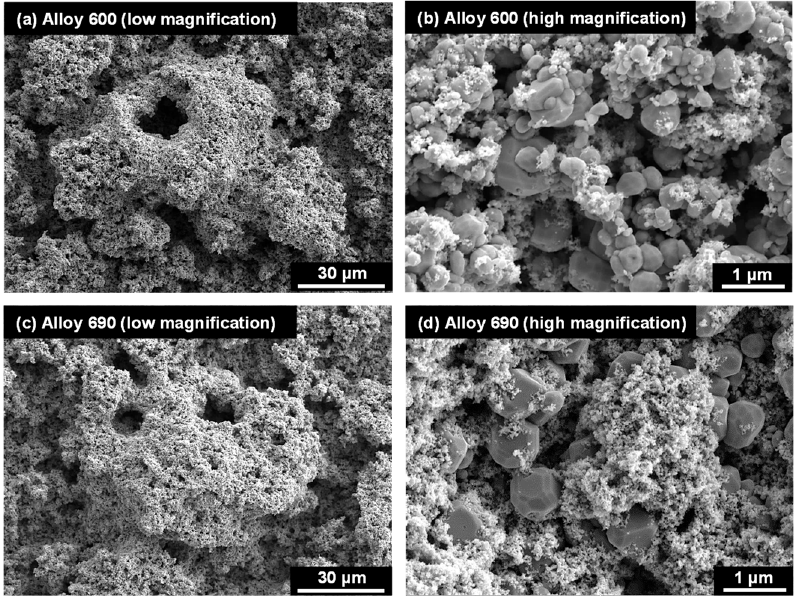
Figure 6. Low ‐ and high ‐ magnification SEM images of SG tube surfaces after the deposition tests: Figure 6. Low- and high-magnification SEM images of SG tube surfaces after the deposition tests: ( a , b ) Alloy 600 and ( c , d ) Alloy 690. ( a , b ) Alloy 600 and ( c , d ) Alloy